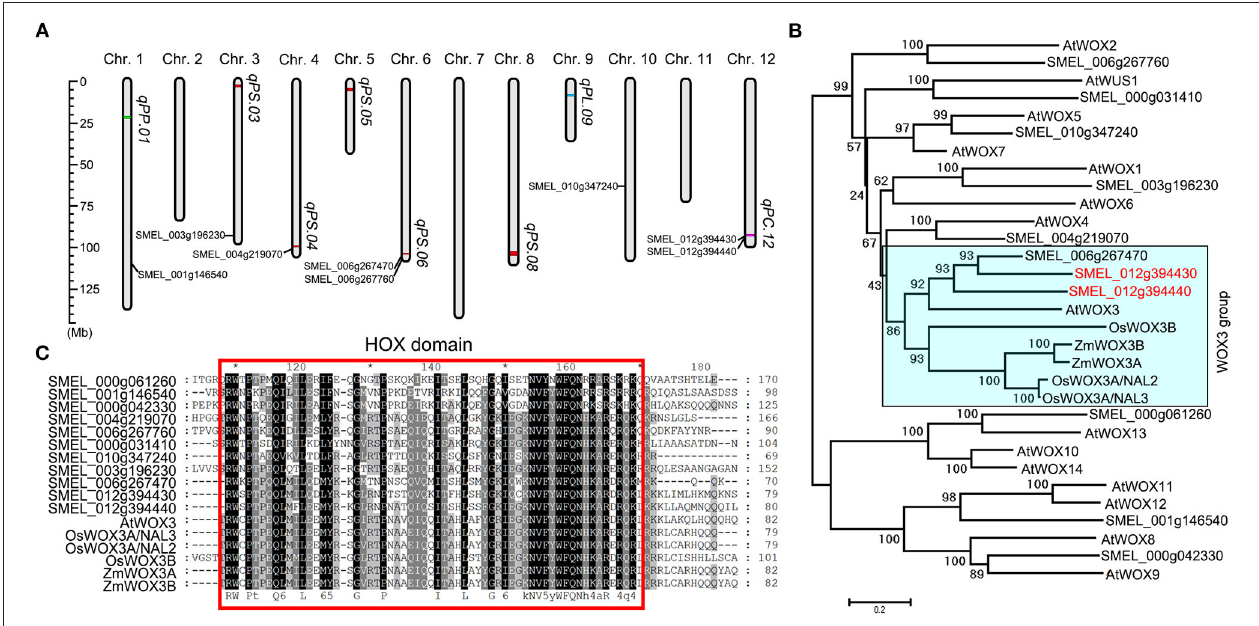
FIGURE 6 | The genome-wide analysis of WUSCHEL gene family in eggplant. (A) The distribution of SmWUS genes and qPS.03 , qPS.04 , qPS.05 , qPS.06 , qPS.08 , qPC.12 , qPL.09 , and qPP.01 on chromosomes in eggplant. (B) The phylogenetic tree of WUS genes in rice, maize, eggplant, and Arabidopsis thaliana . The two eggplant WUS genes in qPC.12 were represented in red. The clade containing WOX3 proteins was in a blue box and designated as the WOX3 group. (C) The alignment of members in the WOX3 group and other SmWUS genes. Conserved HOX domains were highlighted with the red